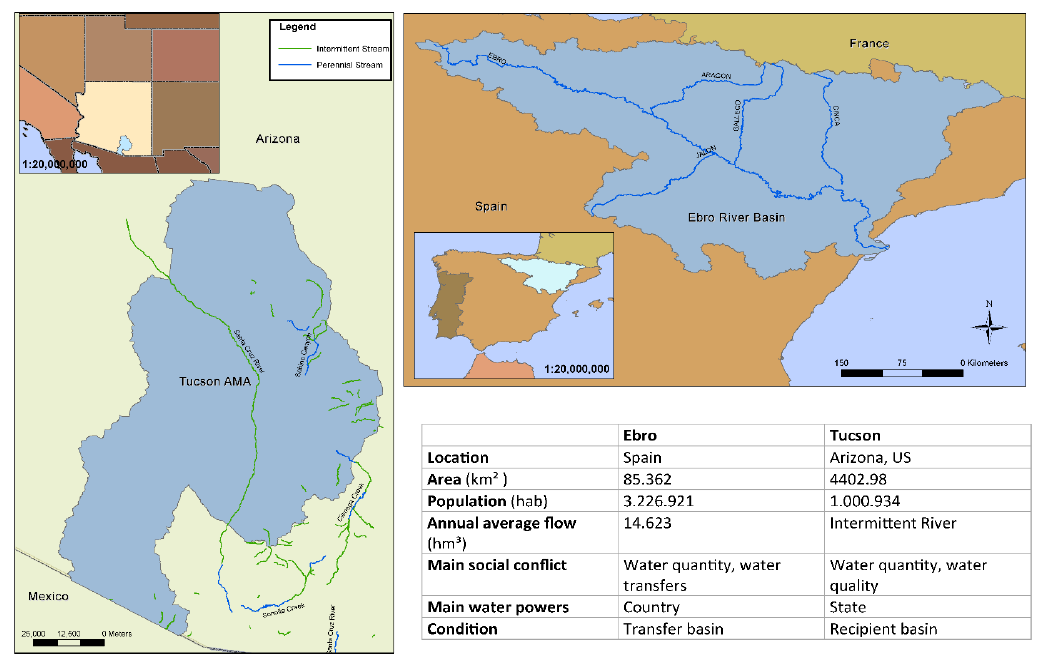
Figure 1. Case study areas and key aspects.